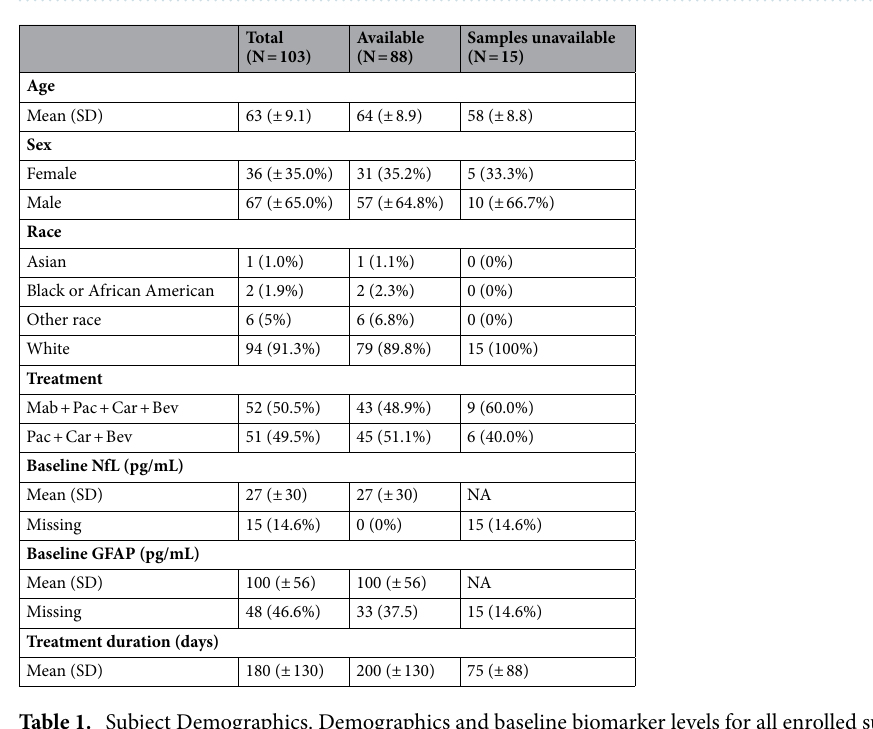
(Fig. 1) 4 . Up to three serum samples were available for each subject: screening (drawn 1 to 15 days prior to treat- ment), prior to dosing on cycle 1 day 1 (C1D1) and prior to dosing on day 1 of cycle 2 (C2D1). NfL was measured in all subjects with at least one available baseline and C2D1 sample and that received at least one infusion of chemotherapy prior to C2D1(88 of 103 enrolled; Table 1); GFAP, tau and UCHL1 were measured in a subset of the available samples (55 of 103 enrolled). Assessment of CIPN. CIPN status and grade was assigned using AE records collected as part of the trial. AE preferred terms believed to represent potentially dose-limiting CIPN were selected by an experienced oncol- ogist. As per CTC-NCI guidelines 11 , AEs classified as grade 1 reflect mild symptoms requiring no specific inter- vention. Grade 2 signified moderate events affecting activities of daily living (ADL). Grade 3 events, the highest grade of CIPN observed in this trial, indicate severe symptoms affecting self-care and ADL. CIPN was reported in 60 subjects (62.5%) in the trial, of which 54 had corresponding NfL data. Lower grade events were more com- mon and tended to occur earlier than higher grades (Fig. 2). Effect of chemotherapy on biomarkers of neurodegeneration.